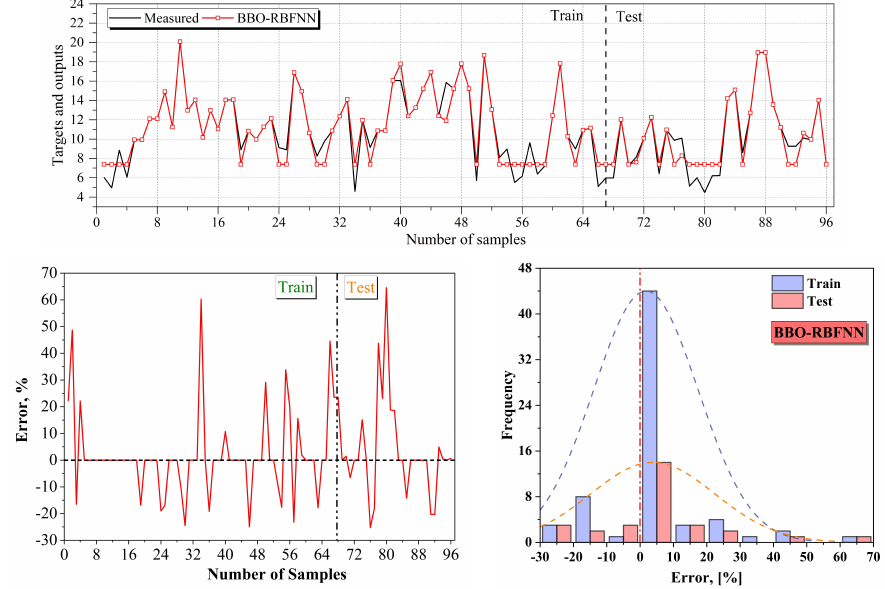
Fig. 11. Train and test stage results of the introduced BBO-RBFNN model in predicting